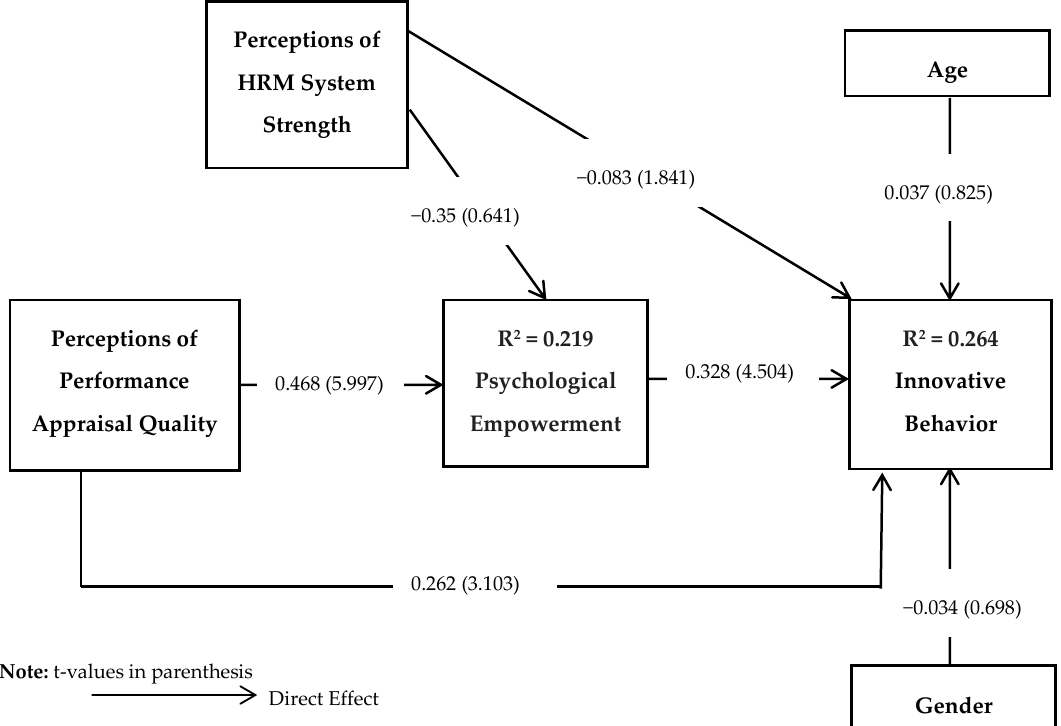
Figure 2. Main Effects Model